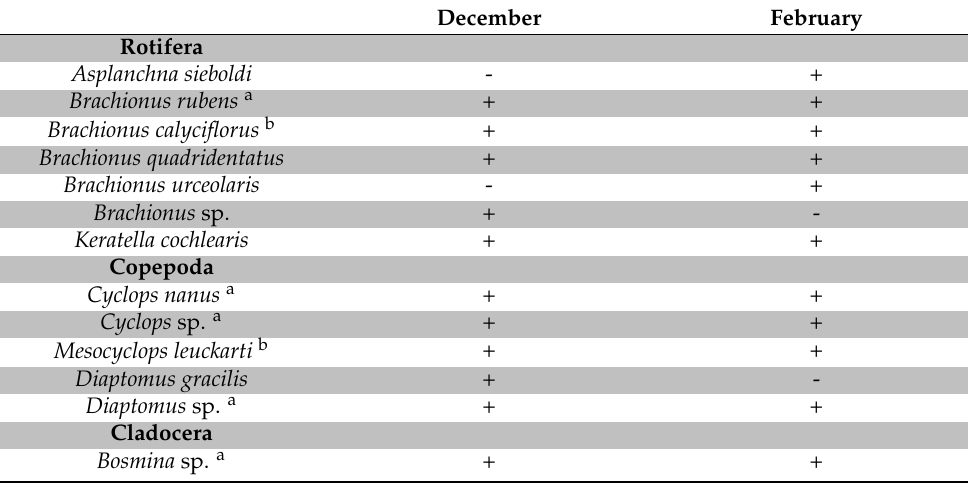
Table 1. Zooplankton species recorded from the homestead ponds of Noakhali